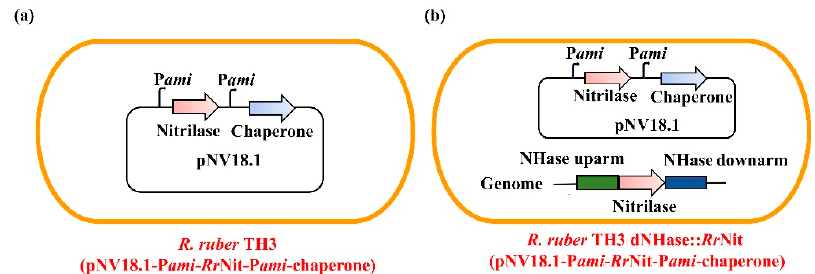
Figure 5. Co-expression design of nitrilase and Rr GroES / Rr GroEL in R. ruber TH3. To improve the expression level, the nitrilase gene was either driven by the strong inducible promoter P ami on plasmid pNV18.1, or inserted into the genome-site of NHase (nitrile hydratase) gene. ( a ) plasmid-only expression strategy; ( b ) genome plus plasmid expression